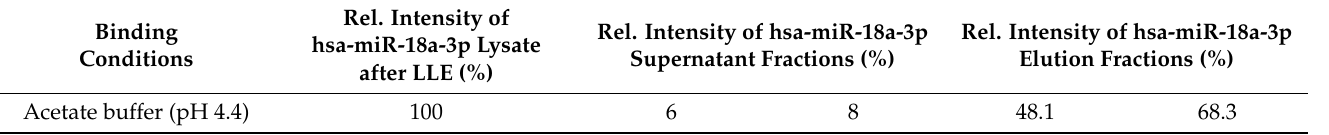
Table 2. The relative yields of hsa-miR-18a-3p in fractions obtained during the isolation protocol from cell lysate spiked with hsa-miR-18a-3p.